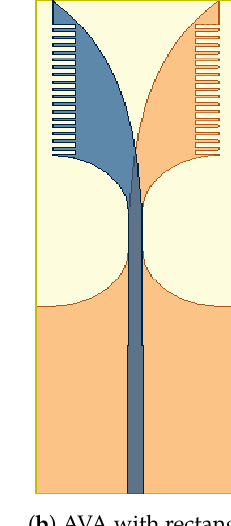
( b ) AVA with rectangular corrugations.